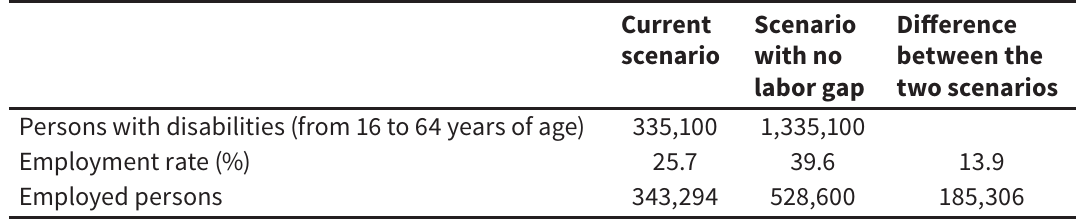
Current situation of people with disabilities in the labor market and basic figures referring to the Scenario with no labor gap, 2014